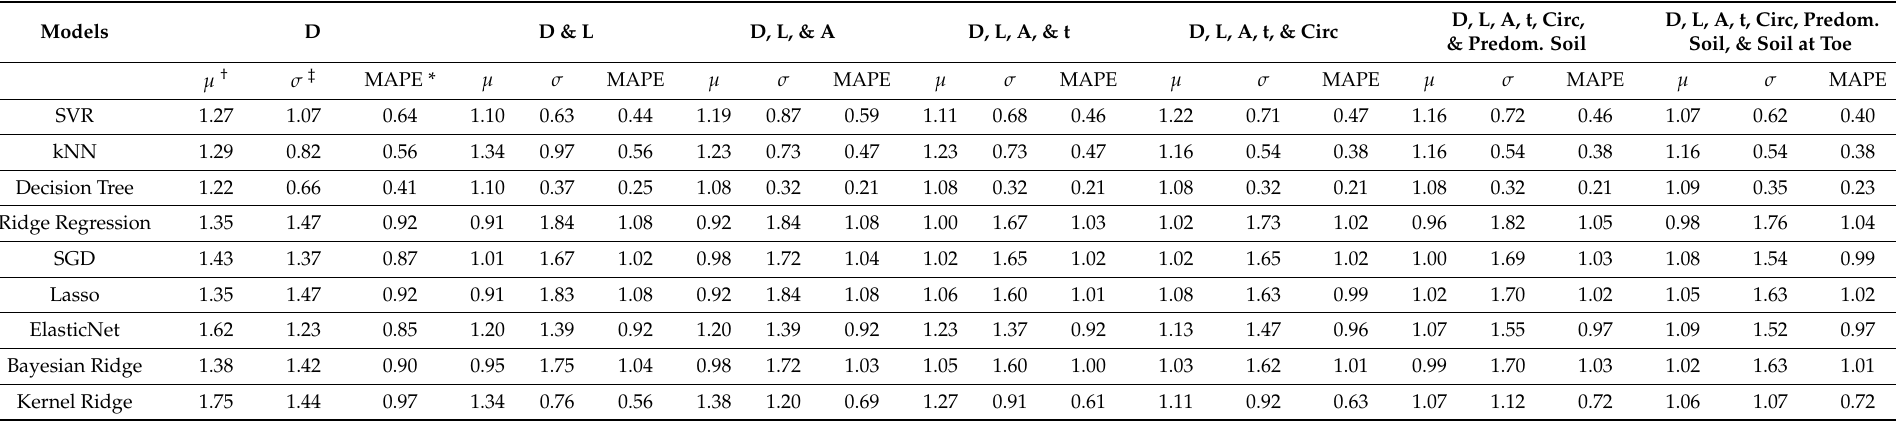
Table 1. Training performance of the models with the various features.